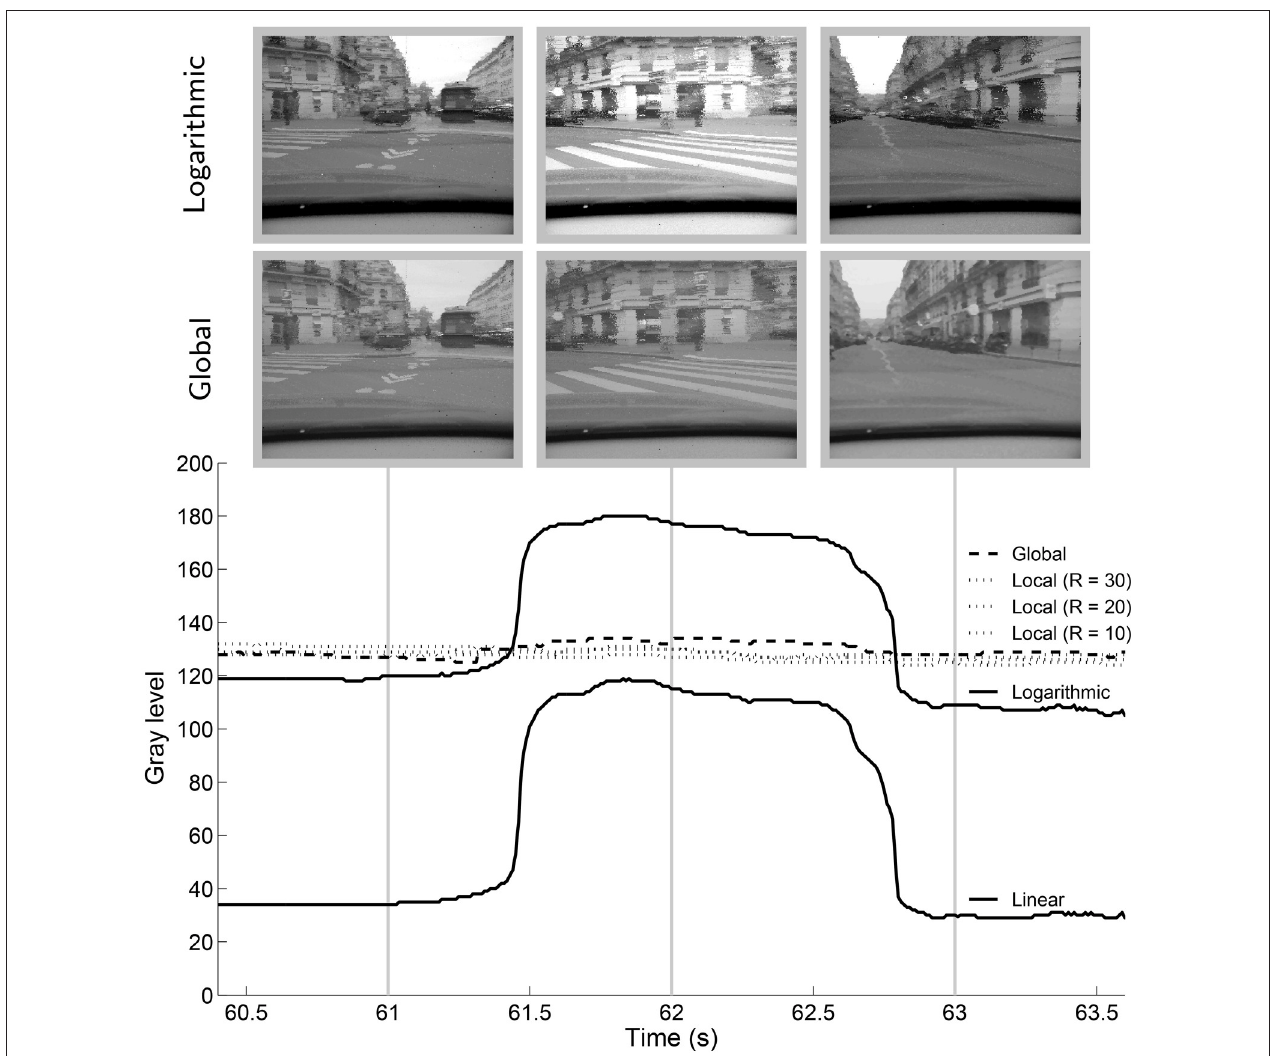
FIGURE 9 | Median of the gray-levels of for a portion of the “city” video for different tone mapping algorithms. The linear and logarithmic tone mapping are run with 5% of the top and bottom of the input dynamic range clamped to extremum display